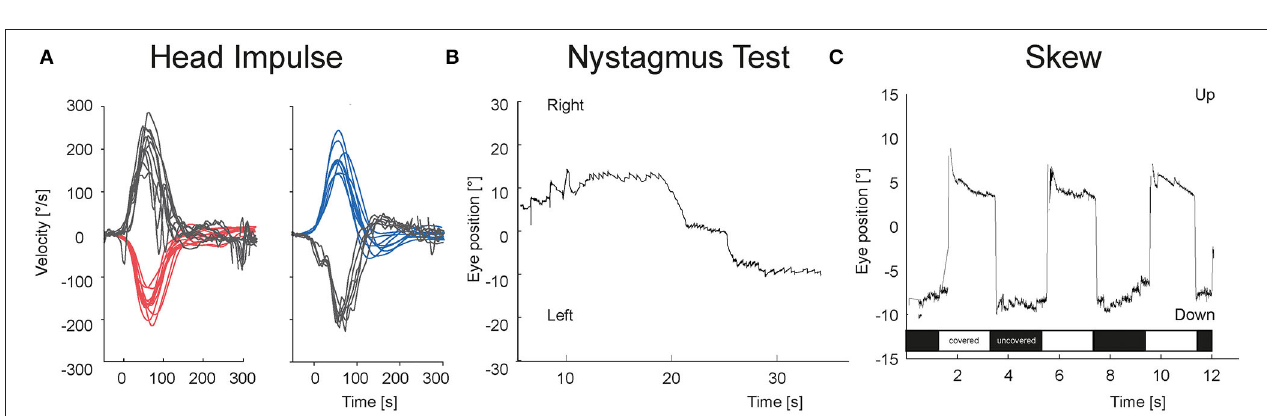
FIGURE 3 | VOG eye recordings of a patient with AUVP are shown. (A) vHIT is abnormal to the left with corrective saccades. (B) Nystagmus is unidirectional at all gaze directions. Panel (C) There is no vertical eye movement in test of skew regardless of whether the right eye was covered (white bar) or uncovered (black bar).